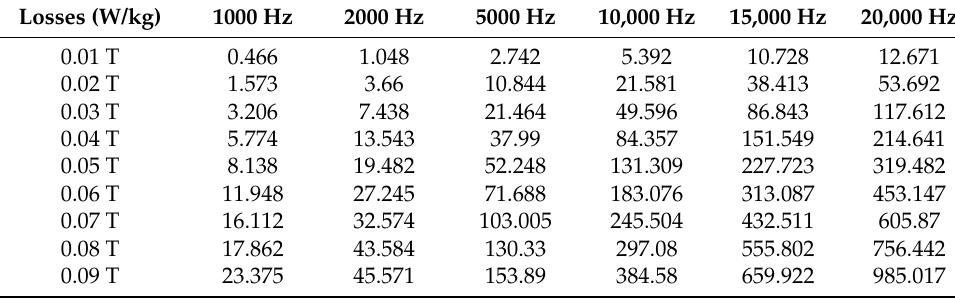
Table 1. Losses at different frequencies and magnetic-flux densities.